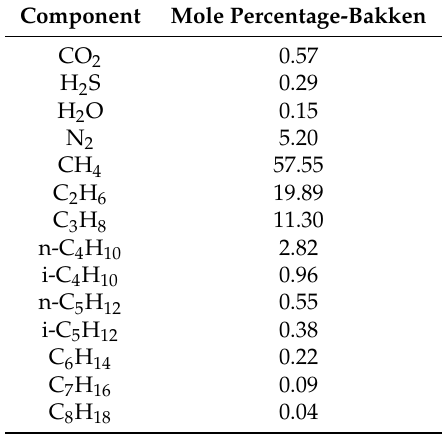
Table A3. Composition of shale gas from the Bakken field in the United States